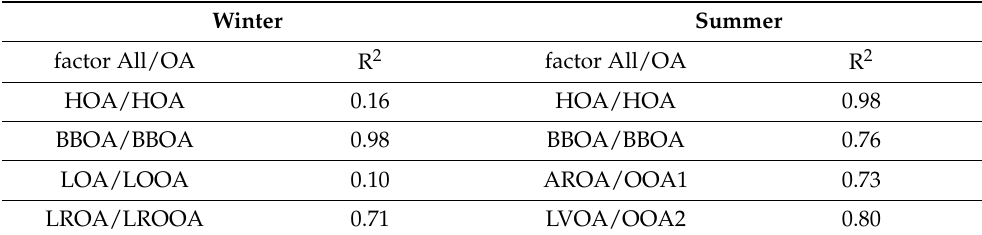
Table 2. The table shows the coefficient of determination for pairs of averaged diurnal cycles obtained by analysis of the organic and combined spectra in the winter and summer seasons. Winter Summer factor All/OA R 2 factor All/OA R 2 HOA/HOA 0.16 HOA/HOA 0.98 BBOA/BBOA 0.98 BBOA/BBOA 0.76 LOA/LOOA 0.10 AROA/OOA1 0.73 LROA/LROOA 0.71 LVOA/OOA2